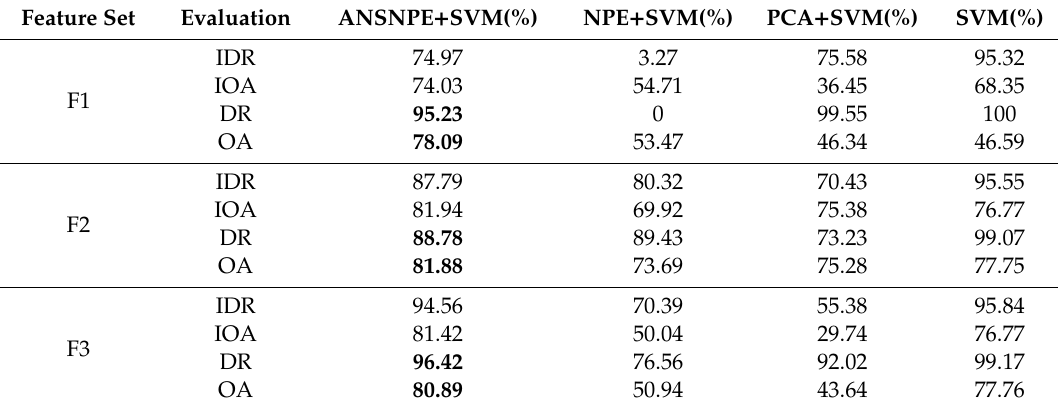
Figure 7. Classification results of the three feature sets. Yellow shows the incorrect building areas, which are extracted; green shows the properly extracted building areas; red shows the building areas not being extracted; and gray shows the non-built areas. Table 5. Extraction accuracy of the three feature